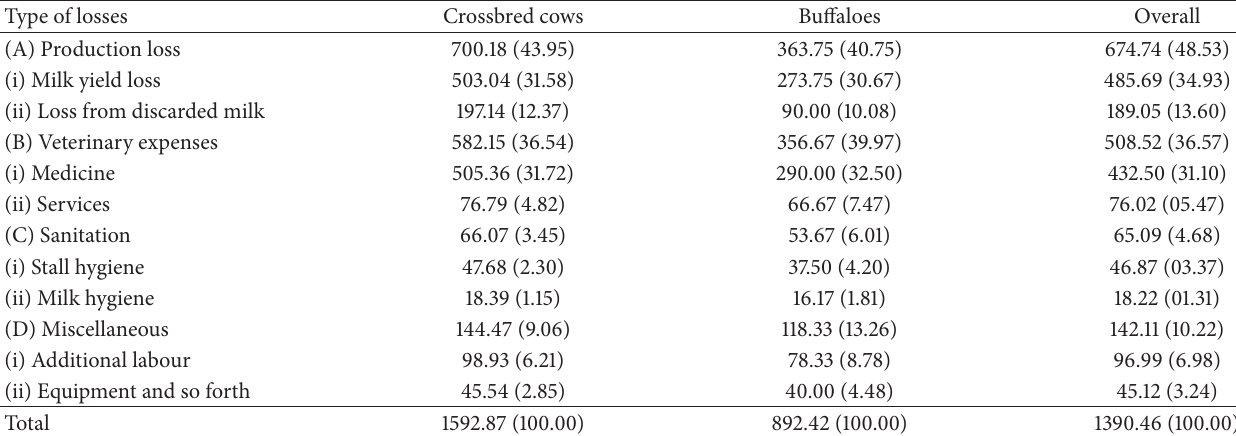
Table 3: Components of losses (in INR) due to mastitis in farm animals.